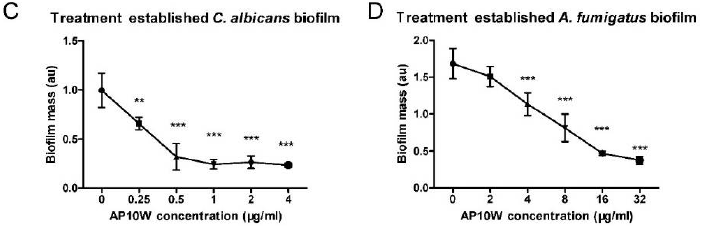
Figure 3. Destruction of C. albicans and A. fumigatus pre-established biofilms by AP10W. ( A ) Micro- scope images of C. albicans biofilm treated for two hours with different concentrations of AP10W (0 − 2 × MFC). Scale bars: 200 µ m. ( B ) Microscope images of A. fumigatus biofilm treated for two